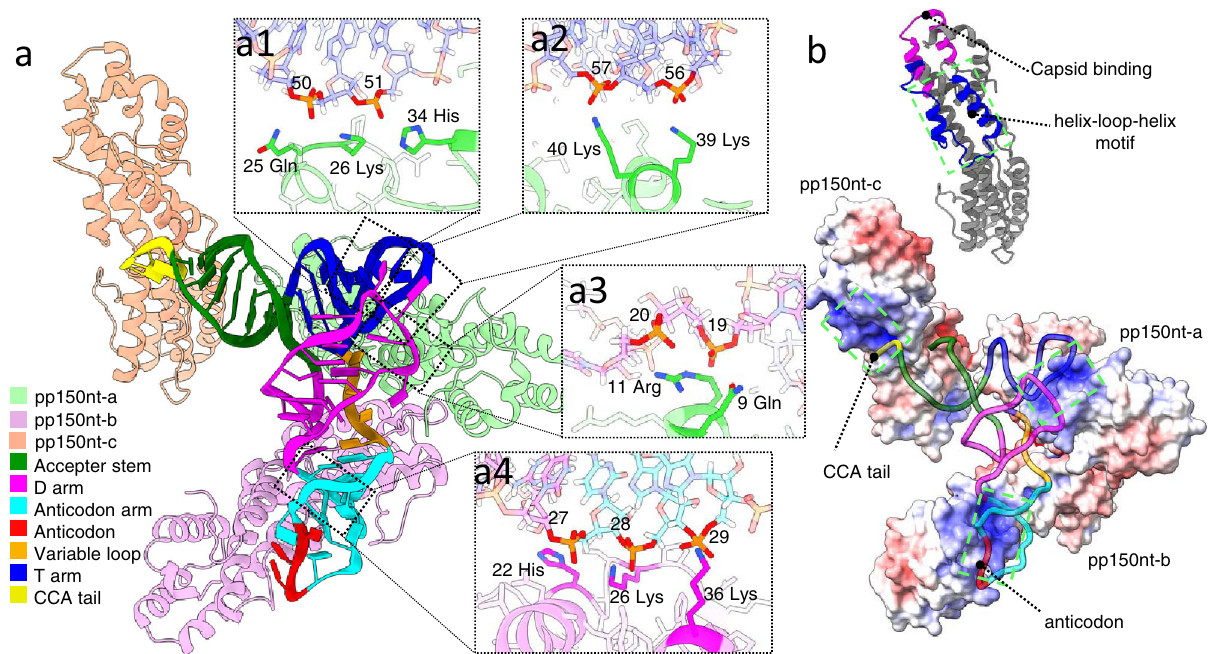
Fig. 2 Interaction between tRNA and set-of-three pp150nt. a Atomic model of tRNA and its three interacting pp150nts. Insets show the identi fi ed tRNA- pp150 interaction sites. b Upper panel: helix-loop-helix (blue) and capsid binding (magenta) motifs on a representative pp150nt model. Bottom panel: a pp150nt map surface colored by electrostatic potential superposed with bound tRNA backbone, shown as